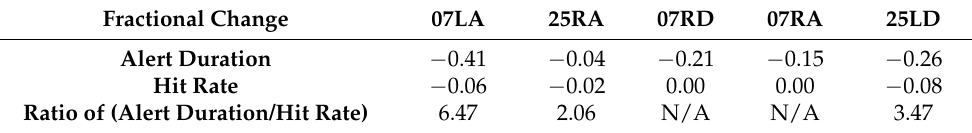
Table 3. Comparison of fractional change in Alert Duration to fractional change in Hit Rate. Fractional